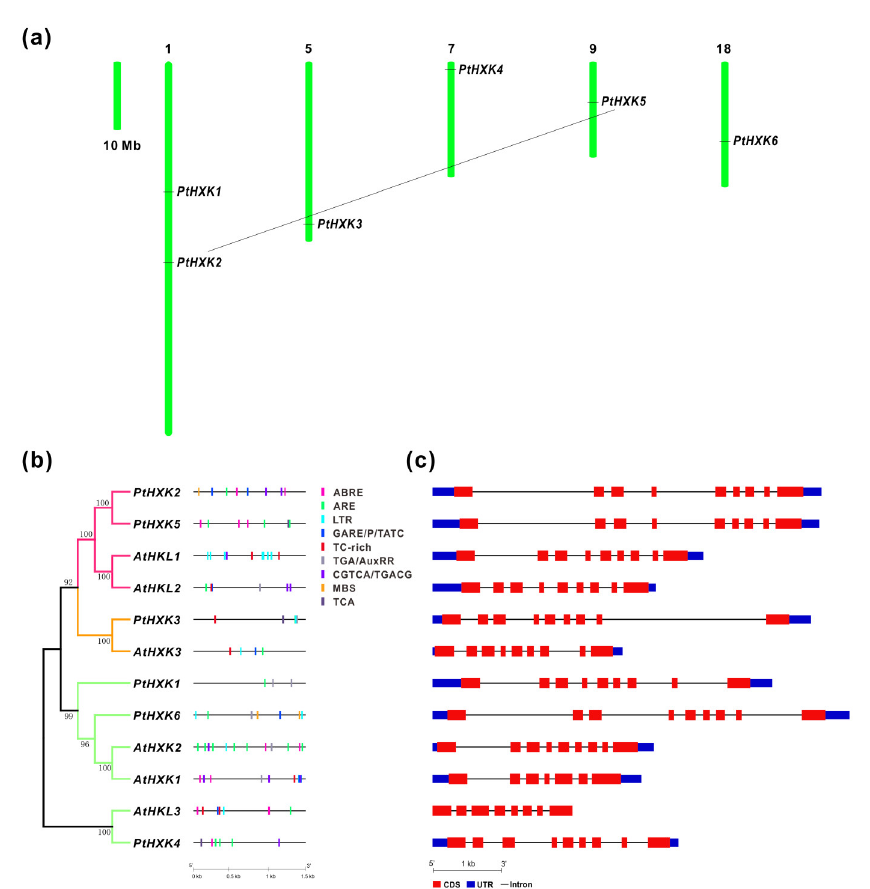
Figure 2. The genomic features of the HXKs between P. trichocarpa and Arabidopsis . ( a ) The chro- mosomal distribution of isogenes shows the duplicated gene pair with a straight line. ( b ) The in silico prediction of the cis -regulatory elements in 1.5 kb gene promoters labeled in colors. ( c ) Ge- nomic structures show the patterns of the exon/intron organization. The exon lengths are displayed proportionally to the scale on the bottom.